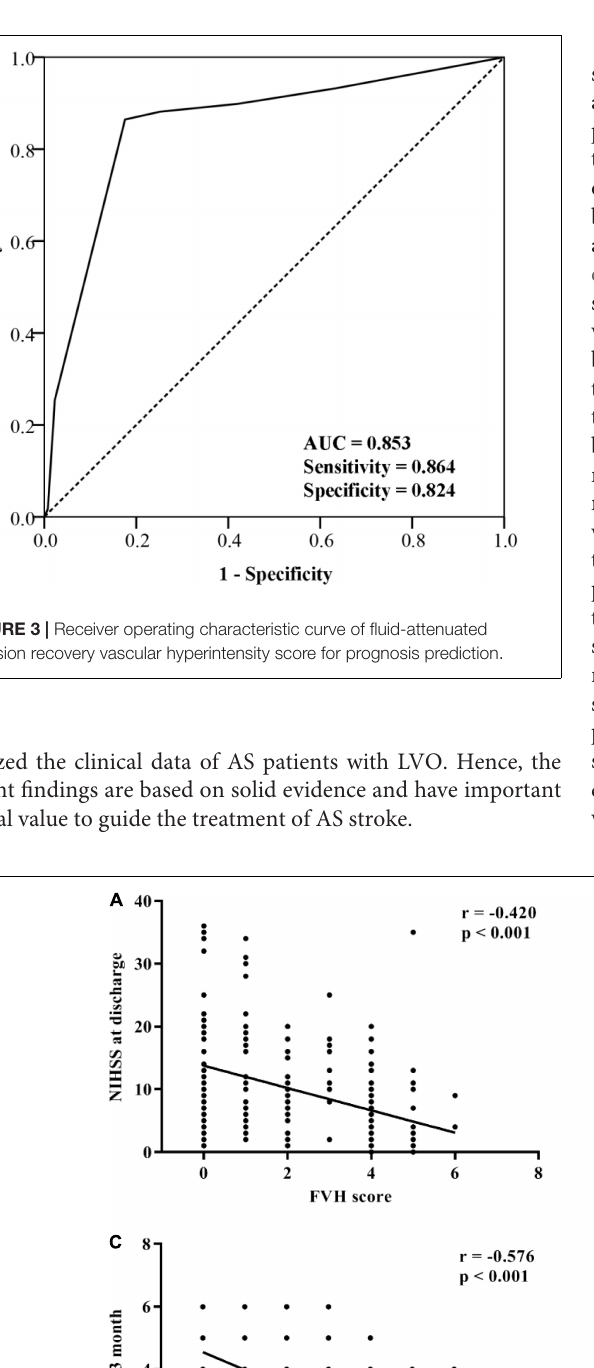
FIGURE 4 | Correlation between fluid-attenuated inversion recovery vascular hyperintensity score and symptom assessments after intravenous thrombolysis. (A) National Institutes of Health Stroke Scale (NIHSS) at admission. (B) Modified Rankin Scale at 1 month. (C) Modified Rankin Scale at 3 months. (D) Modified Rankin Scale at 6